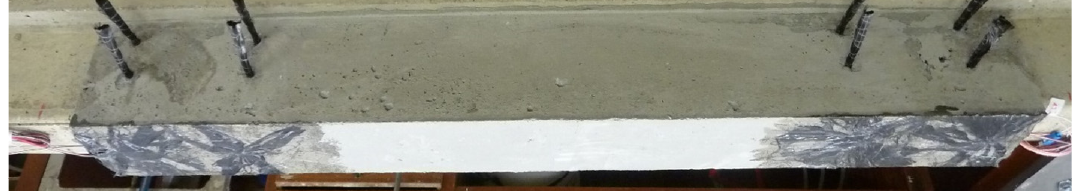
Figure 2. Anchorage system for TRM-strengthened beams.